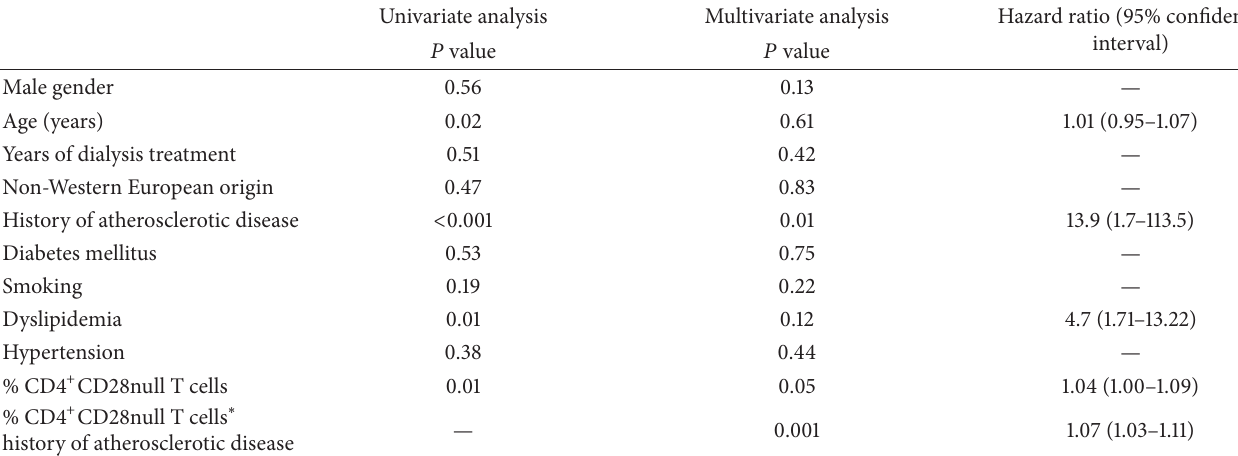
Table 2: Univariate and multivariate analysis of clinical and demographic parameters in association with the incidence of an atherosclerotic vascular event within the first year after kidney